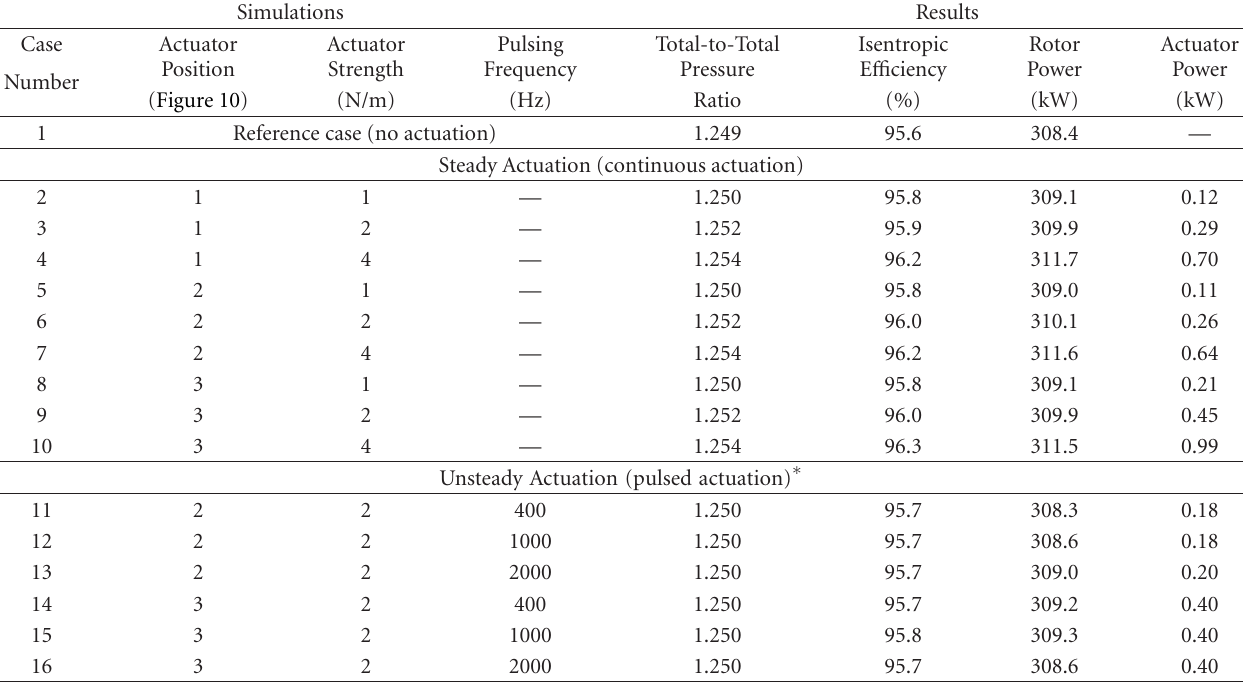
Table 2: Simulated cases and results.